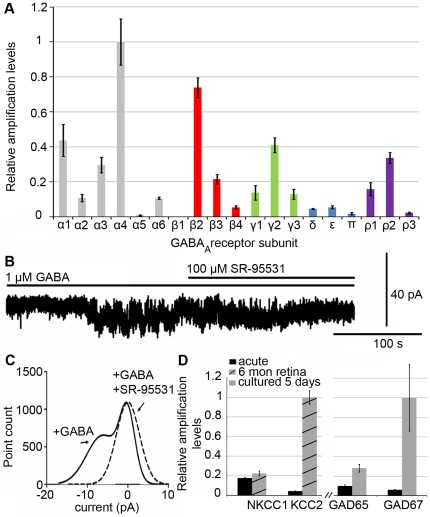
Characterisation of the GABAA receptor system in NPE cells.(A) Relative qRT PCR amplification levels of the 19 GABAA receptor subunit mRNA in NPE cells. Grey columns for α subunits, red columns for β subunits, green columns for γ subunits, blue columns for δ, ε, π subunits and purple columns for ρ subunits. Error bars ±SD, n = 4 independent preparations each containing a pool of more than 10 NPE. (B) Electrophysiology of dissociated NPE cells. 1 µM GABA activated currents (−90 mV holding potential) that were inhibited by application of the GABAA receptor antagonist SR-95531 (100 µM). n = 5. (C) Gaussian fits to all-points histograms derived from the current record shown in (B): solid line, currents after GABA application; broken line, currents after application of SR-95531. The difference between the two peaks in the presence of GABA equals the mean tonic current (−6.2 pA). (D) Relative qRT PCR amplification levels of NKCC1, KCC2, GAD65 and GAD67 mRNA in acute NPE cells compared to 6 months old retina (NKCC1 and KCC2) or cultured NPE cells (GAD65 and GAD67). Error bars ±SD, n = 4 as above.